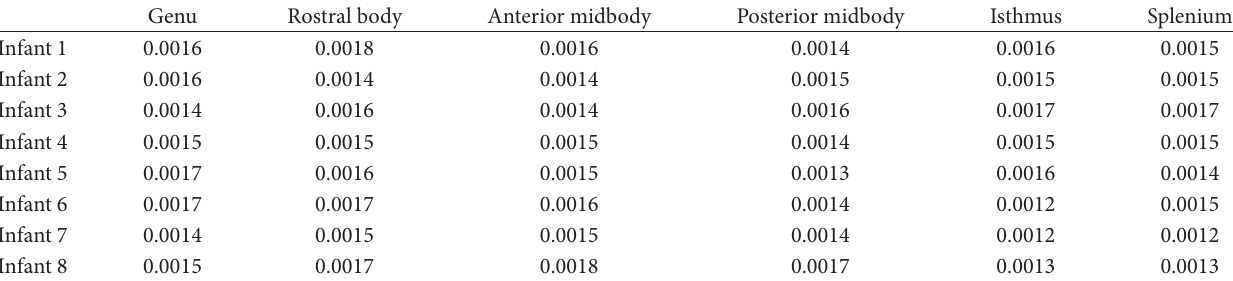
T 3: Corpus callosum mean diffusivity values for each infant.